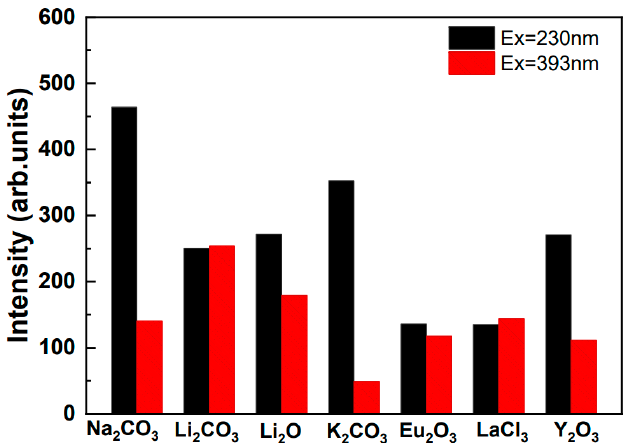
Figure 3. Effect of co-doping on the PL intensity of Eu 3+ ions excited by 230 nm and 393 nm, respec- tively.